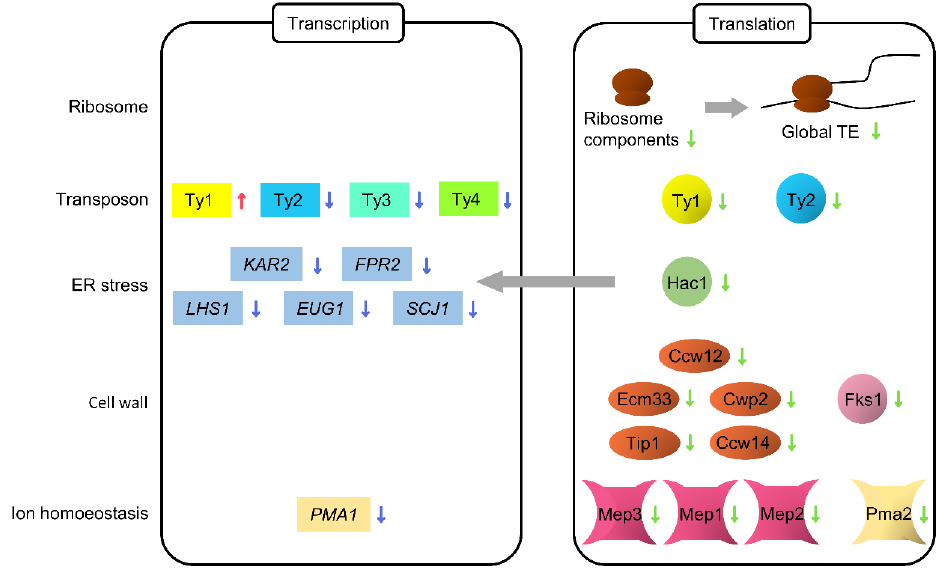
Figure 9. Possible transcriptional and translational regulation during replicative aging in yeast. The grey arrow shows the regulation by the transcription factor, Hac1.